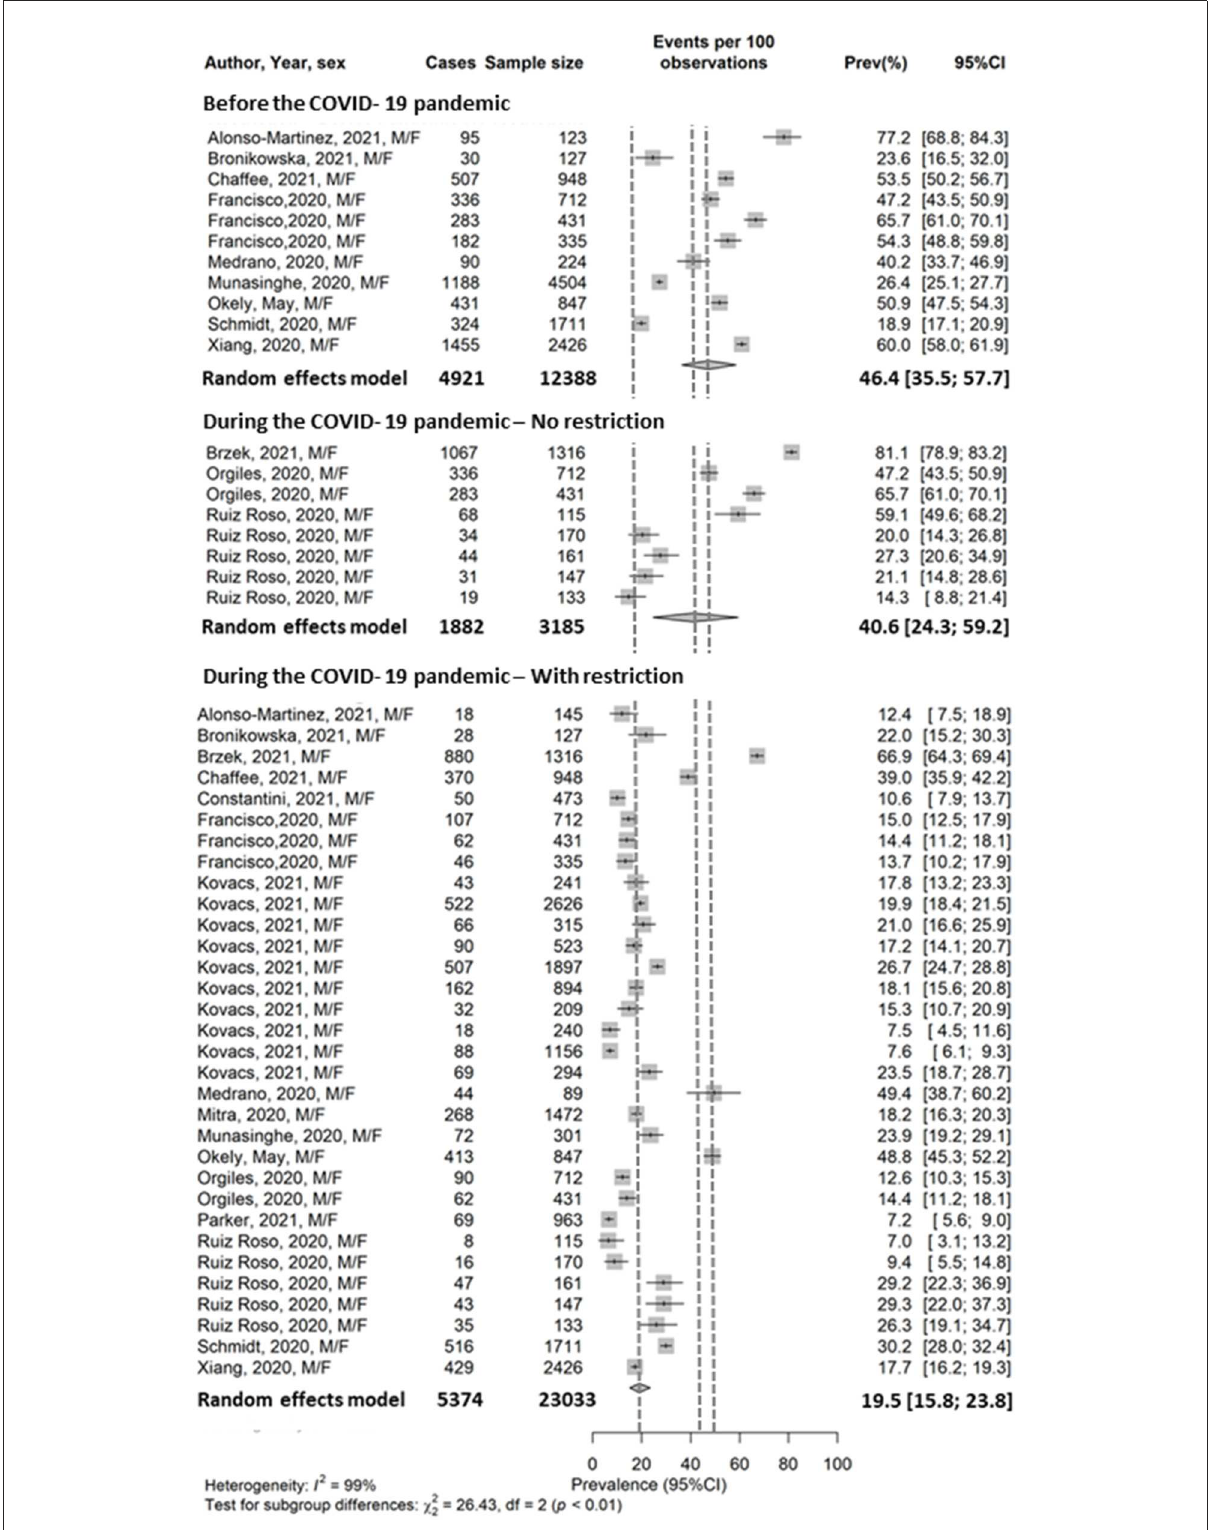
FIGURE2 Pooled prevalence of physical activity in the child general population. Francisco et al. (38) reported PA data from Italy, Spain, and Portugal. Orgilés et al. (39) reported PA data from Italy, and Spain. Ruiz-Roso et al. (40) reported PA data from Brazil, Chile, Colombia, Italy, and Spain. Kovacs et al. (41) reported PA data from France, Germany, Hungary, Italy, Poland, Portugal, Romania, Russia, Slovenia,